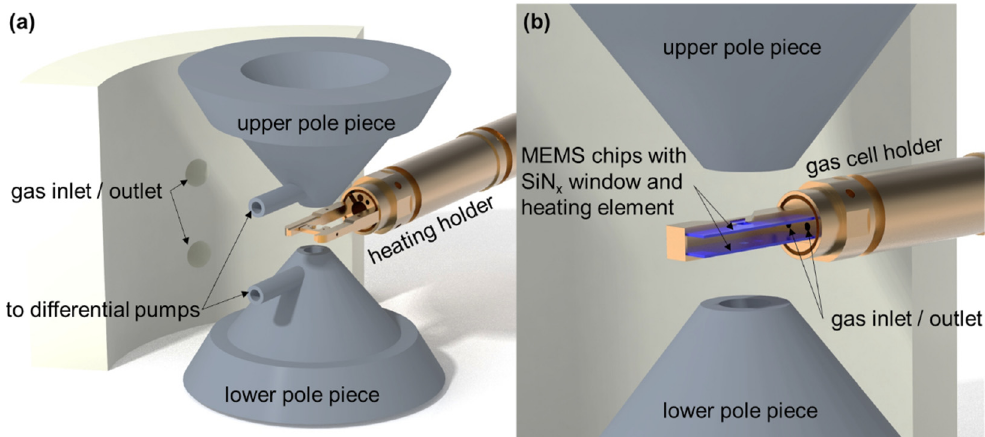
Figure 1. Comparison between environmental transmission electron microscopy (ETEM) and windowed gas cell systems. ( a ) is a schematic of an ETEM system. ( b ) is a schematic of a windowed gas cell inside a conventional TEM.